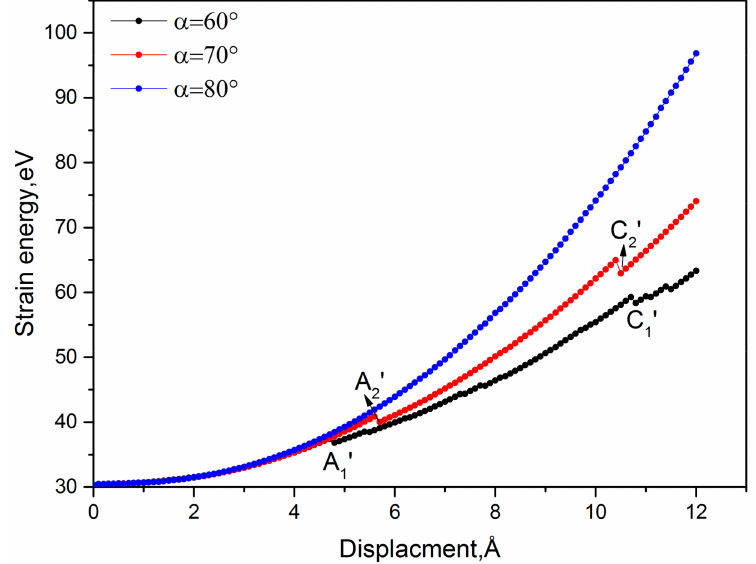
Figure 10. Strain energy-displacement responses of wedged nanoindentations with half vertex angles of 60 ◦ , 70 ◦ and 80 ◦